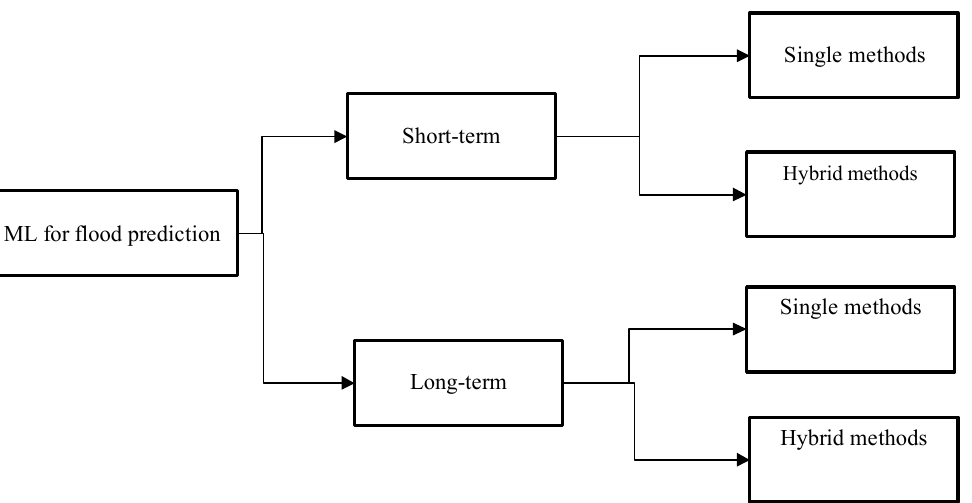
Figure 5. Taxonomy of the survey—ML methods for flood prediction.